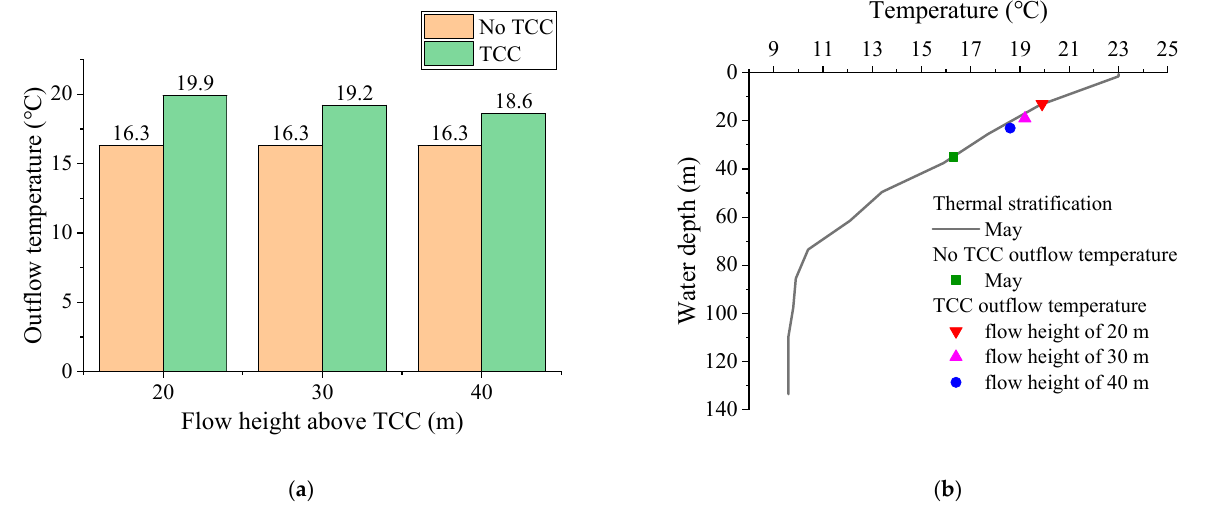
Figure 11. Comparison of outflow temperature: ( a ) before and after TCC implementation; ( b ) different flow height.